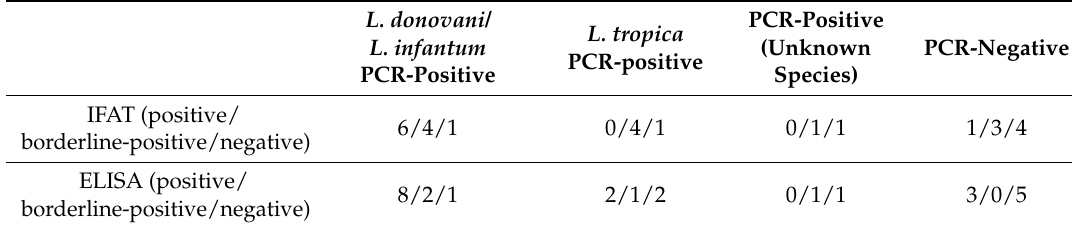
Table 3. For 26/86 serum samples tested by both ELISA and IFAT, a PCR result was available (please see text for